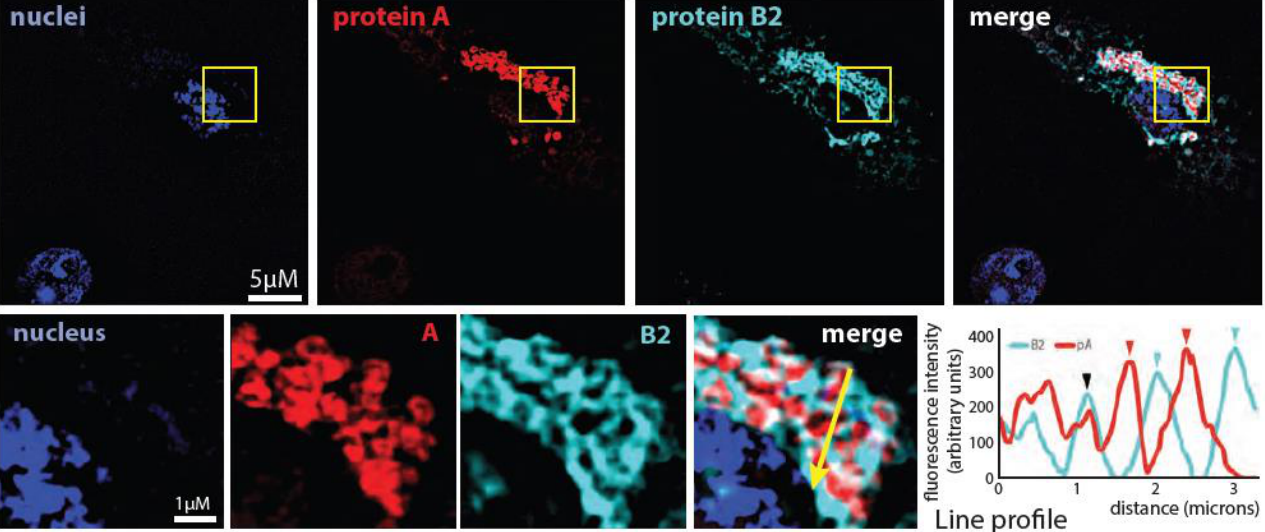
Figure 2. Subcellular localization of nodavirus proteins A and B2 in infected cells. Super-resolution Structural Illumination Microscopy (SIM) reveals that in nodavirus-infected cells, protein B2 localizes near the sites of protein A at mitochondria. Higher magnification insets show that protein A and B2’s localization is predominantly at distinct adjacent sites and that even at the resolution of light microscopy only small portions of their distributions overlap, as further demonstrated by fluorescence intensity measurements across a selected line profile (yellow arrow) in the lower right panels. Blue and red arrowheads indicate separate, distinct localization of proteins B2 and A, respectively; a black arrowhead indicates their occasional